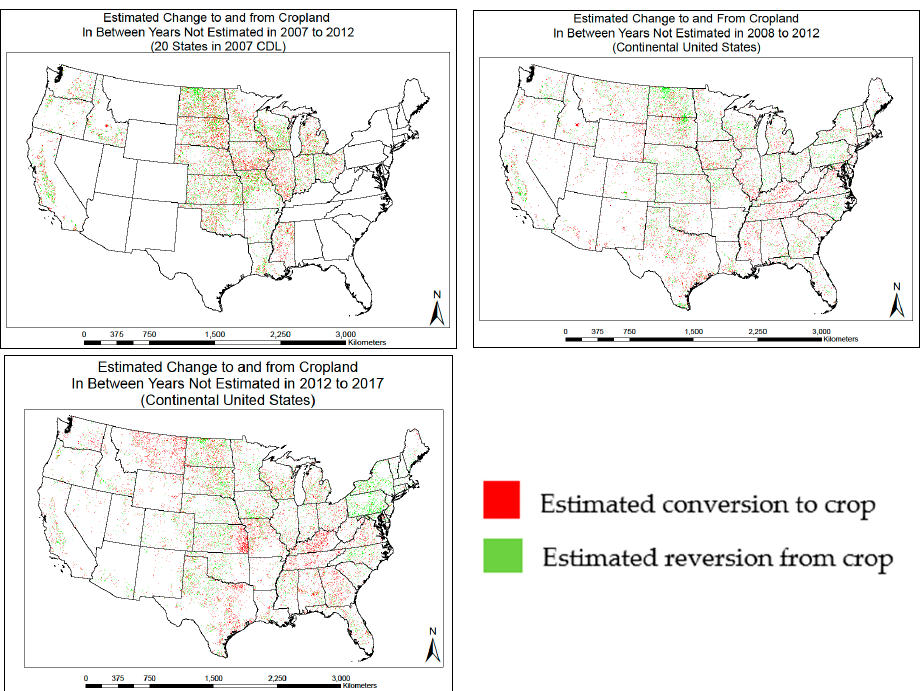
Figure 10. Distribution of estimated cropland change across the 20 states for 3007 to 2012 and continental U.S. for 2008 to 2012 and 2012 to 2017 occurring in years between (red and green) but not in a direct year to year analysis using the Cropland Data Layer. Change estimated in direct year to year comparison is colored white to overlay between years (red and green).